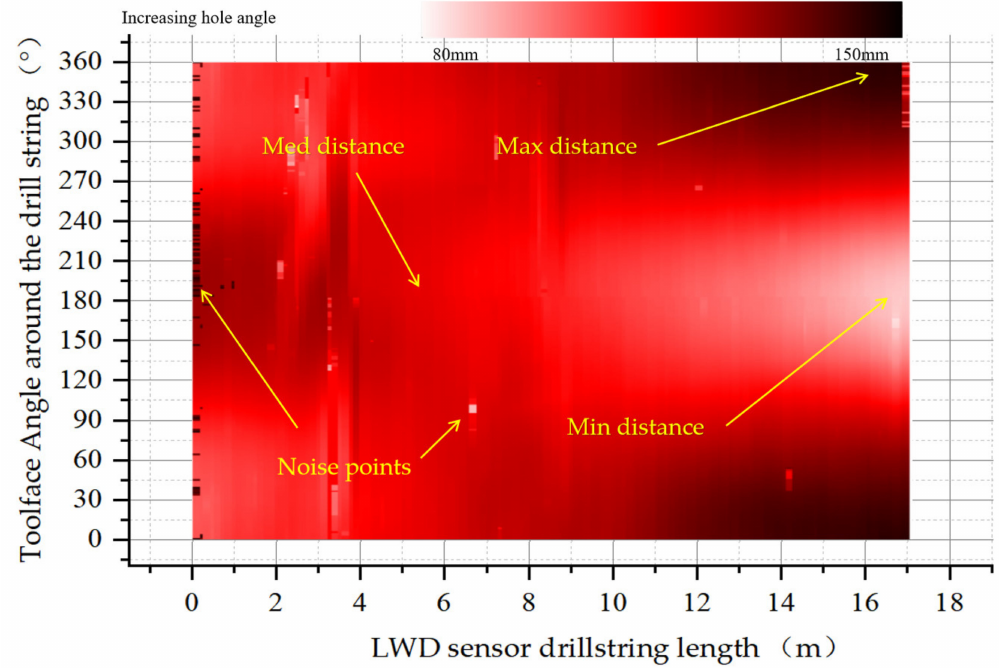
Figure 21. Eccentricity distribution of each tool surface along the drill collar